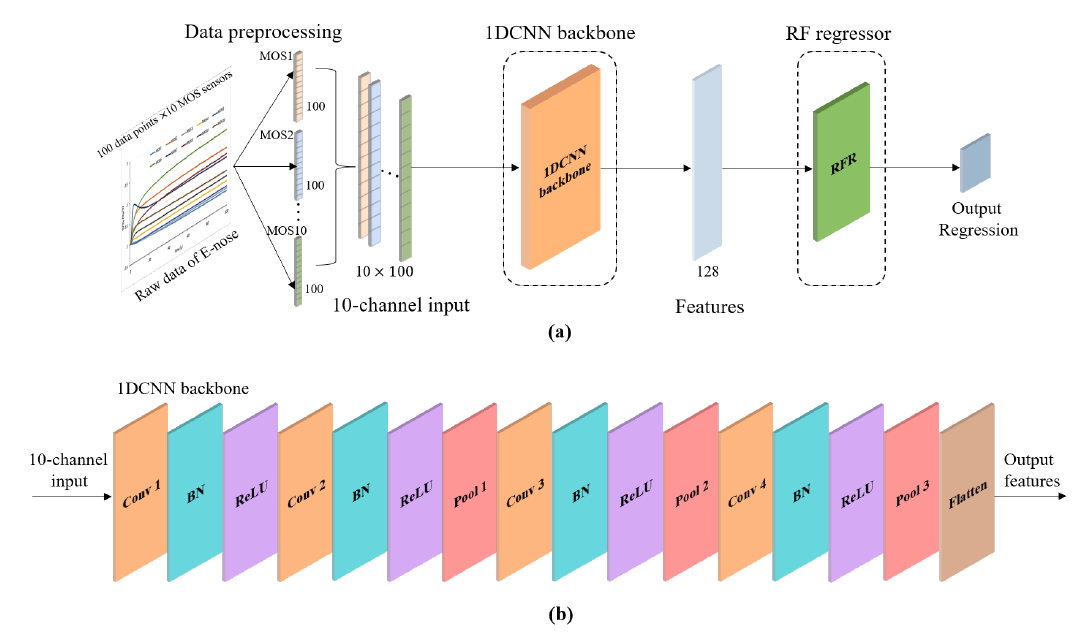
Figure 3. Schematic diagram of the proposed framework. ( a ) Structure of the proposed 1DCNN-RFR framework; ( b ) structure of the proposed 1DCNN